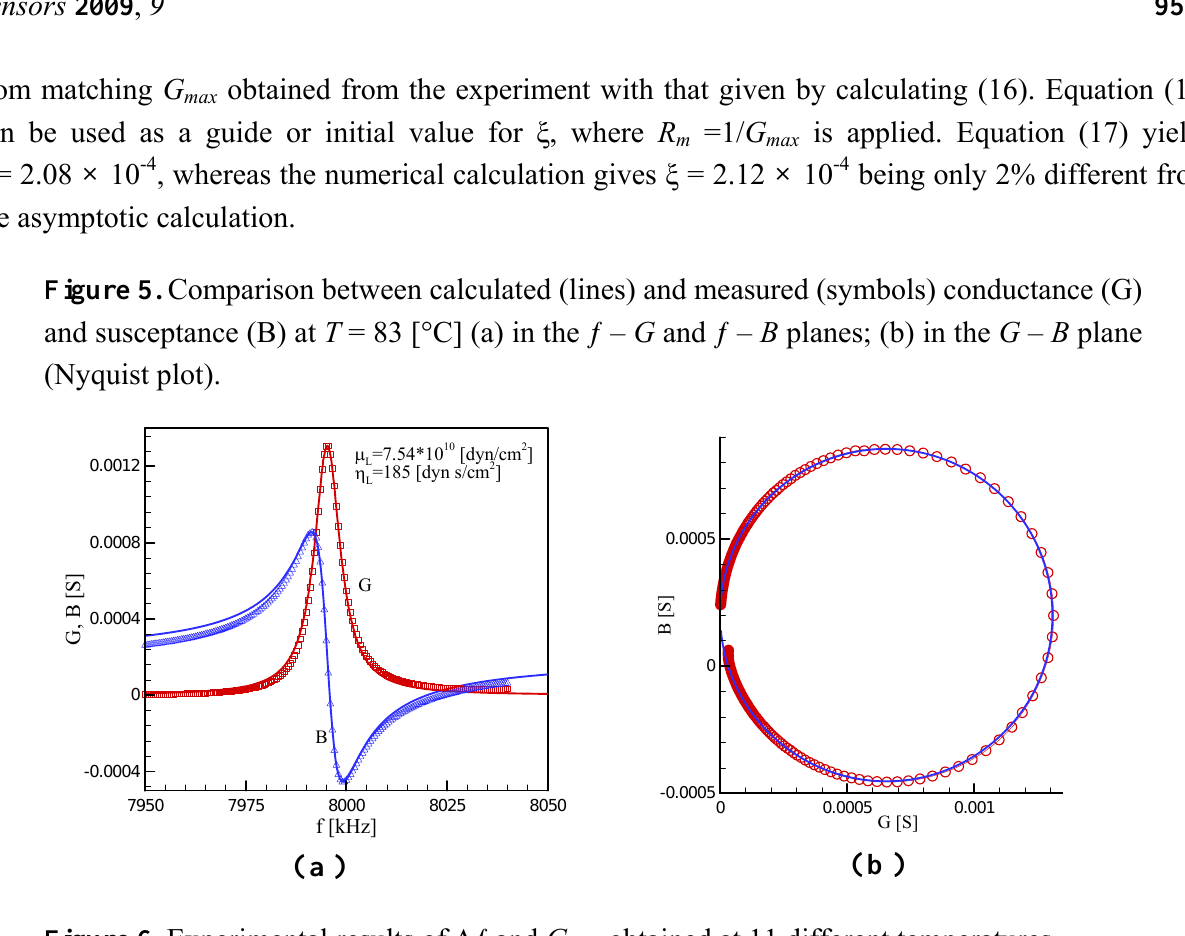
Figure 6. Experimental results of ∆ ƒ and G